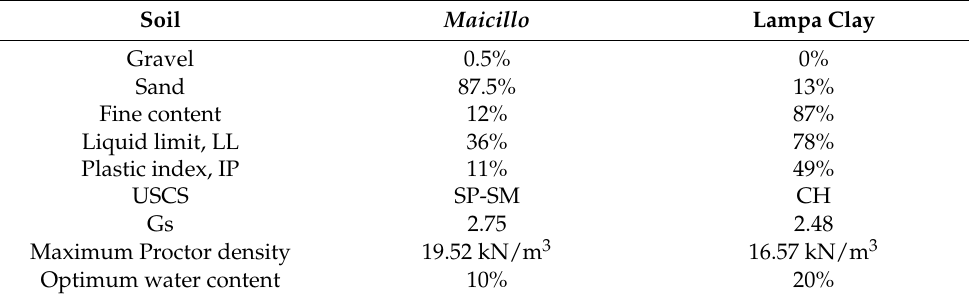
Table 2. Characterization of soils.